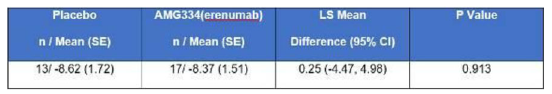
Table 1 (abstract P162). Change from baseline in Monthly Migraine Days at Week